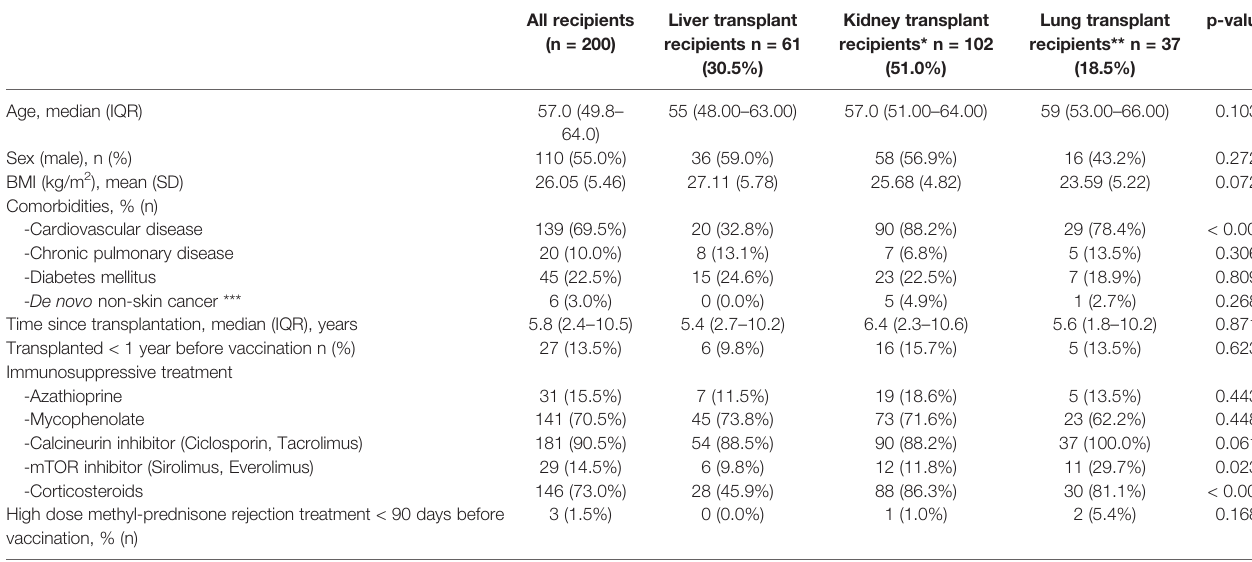
TABLE 2 | Characteristics of SOT